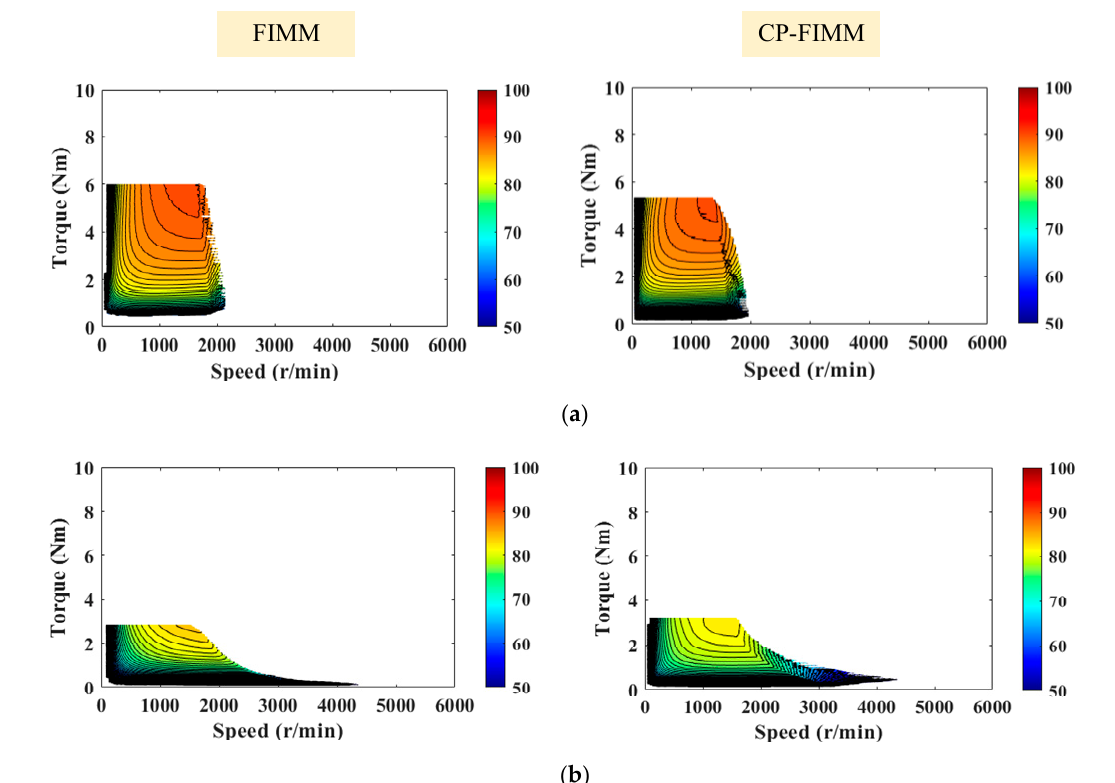
Figure 16. Efficiency maps of FIMM and CP-FIMM. ( a ) Flux-enhanced; ( b ) flux-weakened.